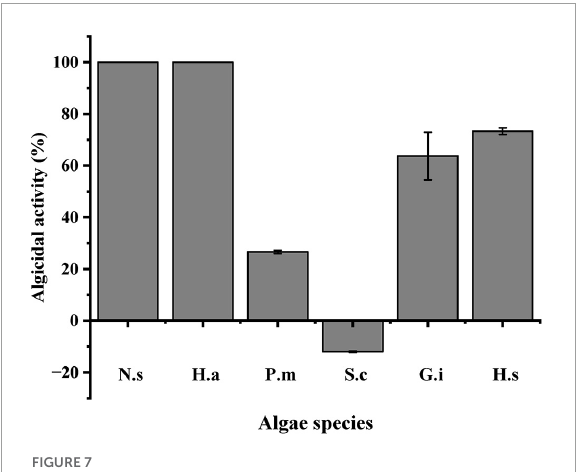
FIGURE7 Algicidal activity of bacterial strain LD-B6 on representative HABs species. N.s, Noctiluca scintillans ; H.a, Heterosigma akashiwo ; P.m, Prorocentrum micans ; S.c, Skeletonema costatum ; G.i, Gymnodinium impudicum ; H.s, Heterocapsa steinii . The error bars represent standard deviations ( n =